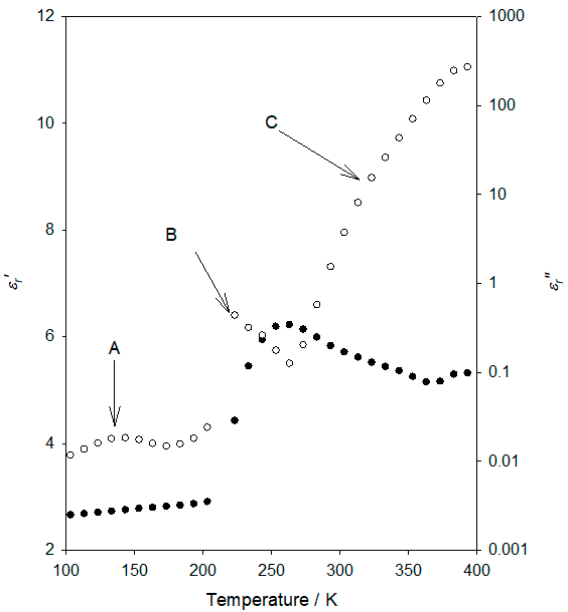
Figure 2. Temperature dependence of the real part of the relative permittivity, ε r (cid:48) ( • , left hand vertical axis) and the imaginary part of the relative permittivity, ε r ” (o, right hand vertical axis), measured at a frequency of 10 Hz.